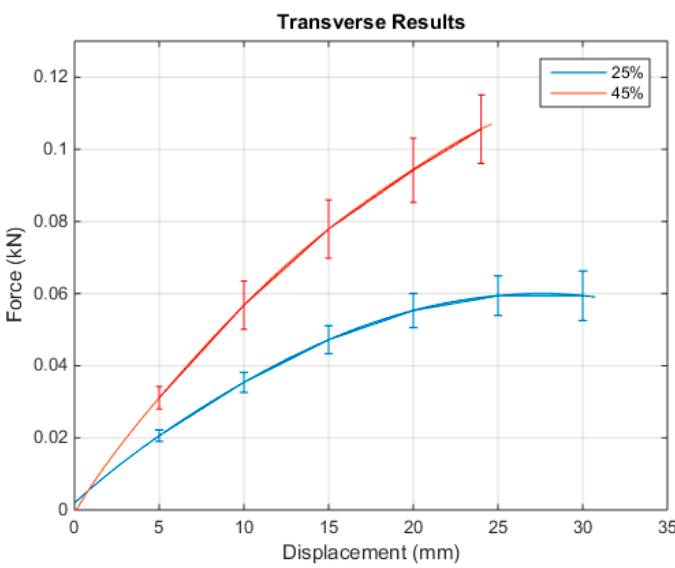
Figure A4. Transverse Results with Standard Deviation Error Bars.